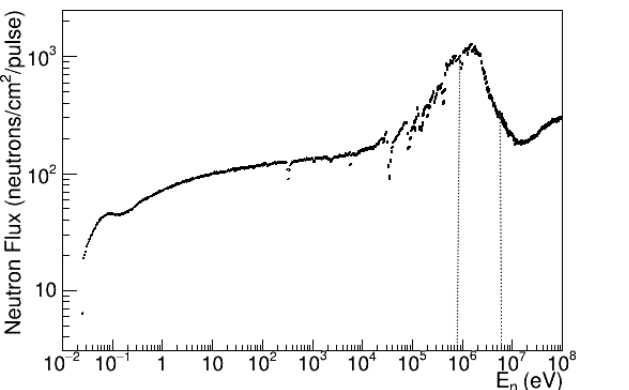
Fig. 3. Neutron Flux at n_TOF EAR1. The dashed lines indicate the region of 800 keV < E n < 7 MeV corresponding to 5 µs < TOF < 15 µs (see discussion in section